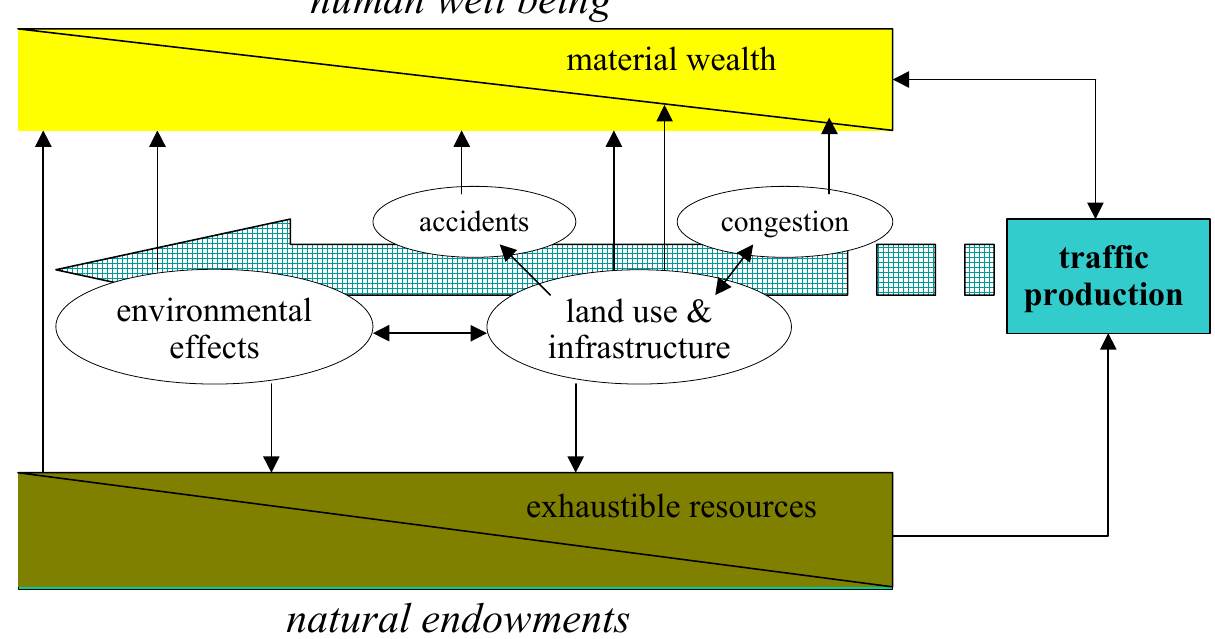
Figure 1. Inter-relationships between natural endowments, traffic production and well being Also the temporal perspective is important for perceiving the possible interactions between the issues. The production (and consumption) of transport in the short run works directly on each of the phenomena (environment, safety, congestion, land use) separately, since the amount, shape and management approach of the infrastructure is largely given. In the medium term the issues of congestion, safety and environment may already feed back directly into land use and infrastructure management. In the longer run the impacts on health and material wealth will affect the volume, composition and spatial pattern of transport directly as well as via planned and market-guided reassessments of land use